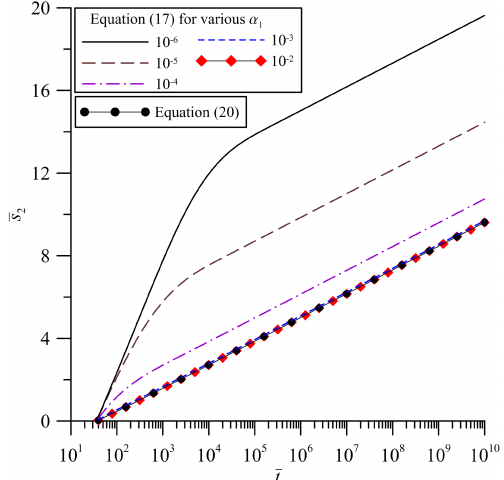
Figure 3. Temporal drawdown distributions predicted by the approximate solution, Eq. (17), with r = 10, z = 0.5, z 1 = 0.4, z 2 = 0.6, r s = 5, γ = 0.1 and various values of α 1 with α 1 = α 2 .